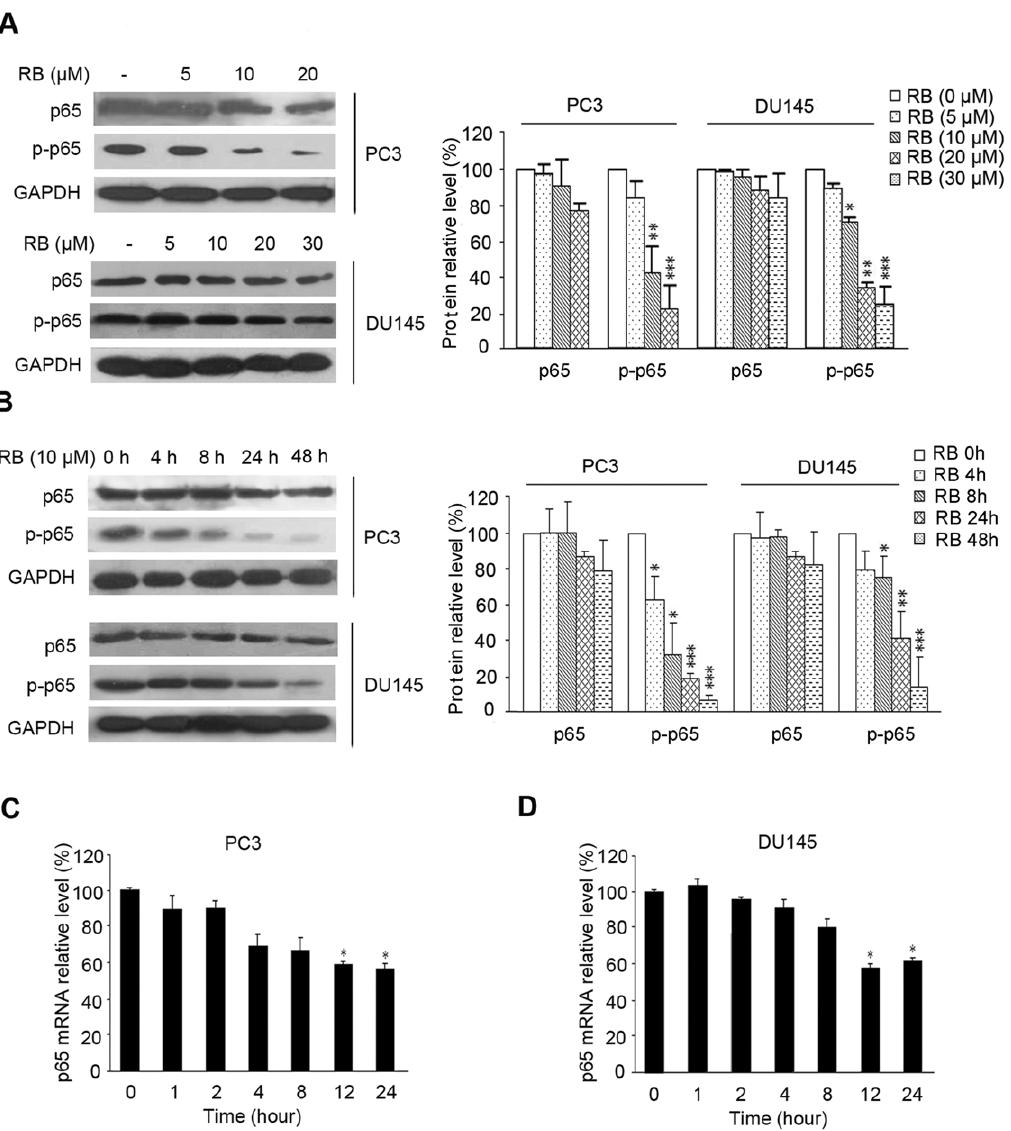
Figure 1. The effect of RB on p65 expression and phosphorylation in PCa cells. (A) and (B) RB slightly inhibited expression of p65 in PC3 and DU145 cells, while significantly for the Ser-536 phosphorylation of p65 ( p–p65 ), in both dosage-dependent and time-dependent manner. Lysates from whole cells treated with RB of different concentrations for 24 h (A) or with 10 m M RB for indicated times were used for western blot (B). GAPDH served as the loading control. Protein amount was normalized to the amount of GAPDH, and was quantified by densitometry of X-ray films. Results of one of at least three independent experiments are shown. (C) and (D) RB moderately down-regulated p65 mRNA level in PC3 and DU145 cells as detected by QRT-PCR assay. The procedure was performed as described in Materials and Methods . Results shown are representatives of three independent experiments, p , 0.05 (*), versus RB-untreated control group respectively.